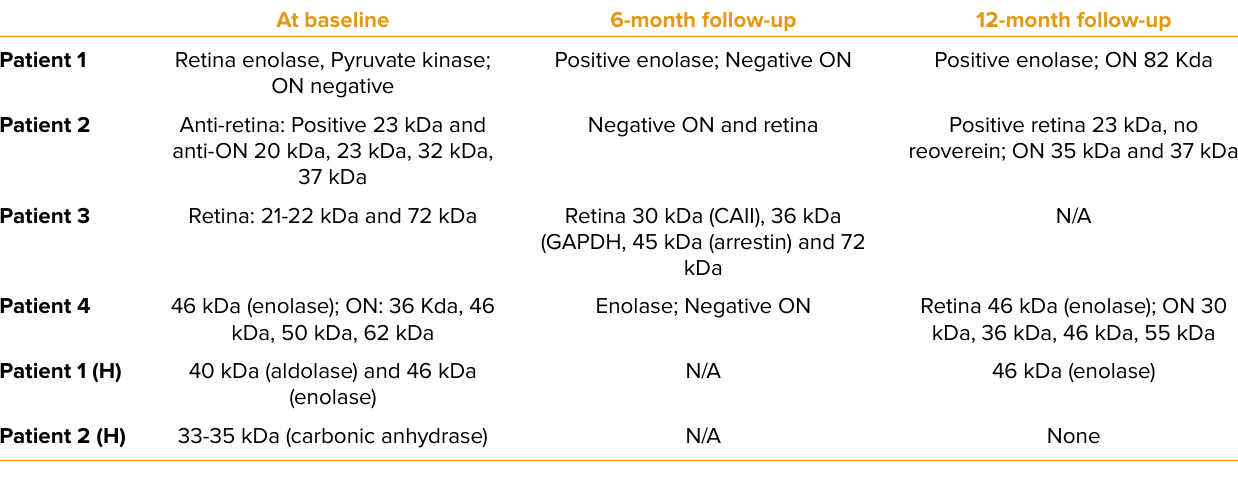
Table 2. Changes in antiretinal and anti-optic nerve antibodies from baseline to 6-months to 12-months in patients on rituximab and bortezomib combination therapy (patient 1–3) and rituximab monotherapy (patient 4).